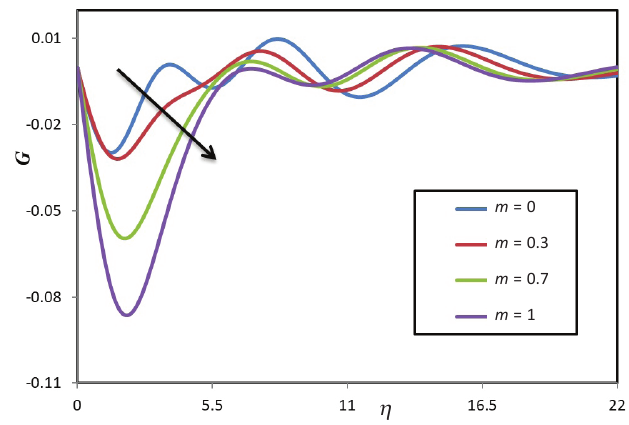
Fig. 7 – G (secondary velocity) versus h for K = 0.5, I = 0.5, F = –0.5 (heat sink), Pr = 100 (weak polymers), Ec = 0.2, with m = 0 (Blasius flow), 0.3 (wedge), 0.7 (wedge), 1.0 (stagnation flow)